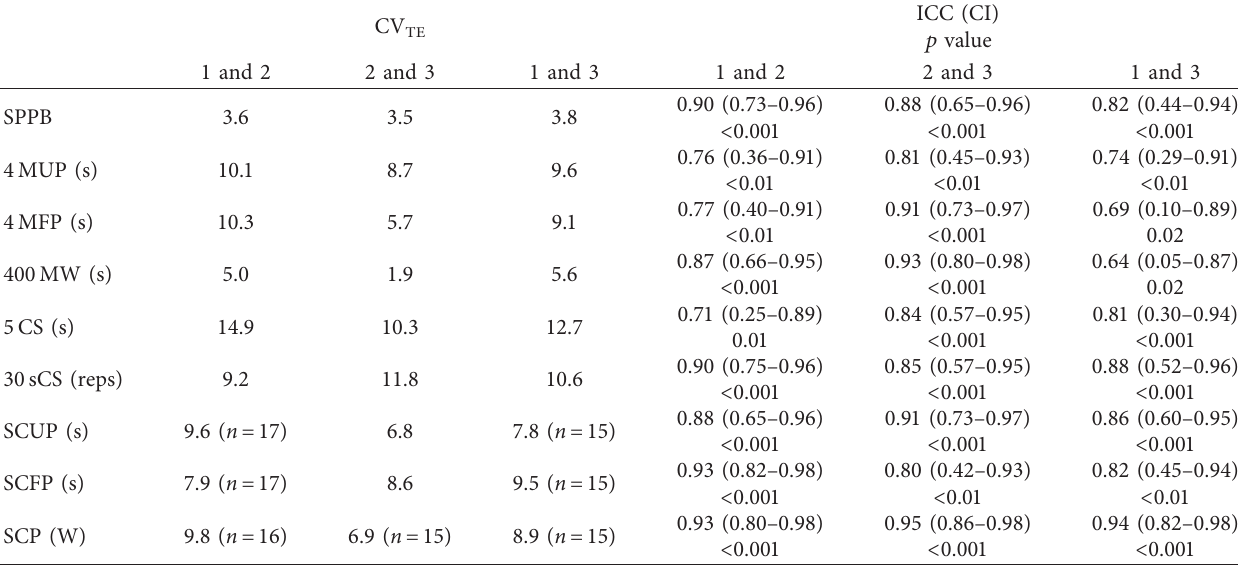
Table 6: Reliability data for functional performance for time points 1 and 2 (weeks 0–9, n � 18), 2 and 3 (weeks 9–15, n � 16), and 1 and 3 (weeks 0–15, n �